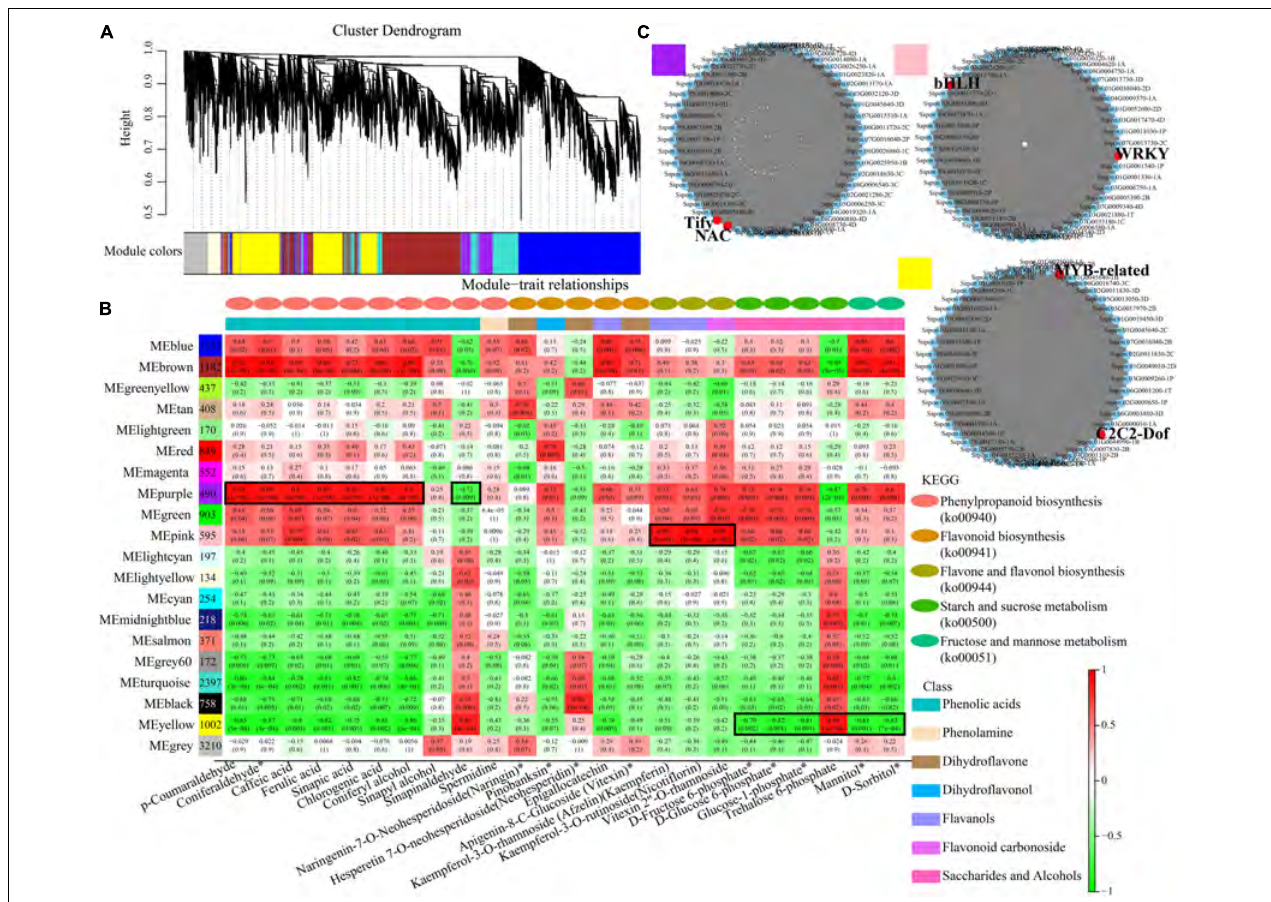
FIGURE 7 | Co-expression network analysis. (A) Hierarchical cluster tree showing 20 modules obtained by weighted gene co-expression network analysis (WGCNA). The gray modules represent genes that are not divided into specific modules. Each branch in the tree points to a gene. (B) Matrix of module-metabolite associations. Combining the gene expression profile data of stem and leaf tissues of different sugarcane varieties and the change patterns of phenylpropanoid biosynthesis, flavone and flavonol biosynthesis, starch and sucrose metabolism, displayed by the WGCNA analysis. The number of genes in each module is shown in the left box, followed by correlation coefficient and p -value between modules and metabolites, which are displayed at the intersection of rows and columns. (C) Co-expression sub-network analysis of purple, pink, and yellow modules related to the accumulation of phenylpropanoid biosynthesis, flavone and flavonol biosynthesis, starch and sucrose metabolism. The first 50 nodes of purple, pink, and yellow modules to build the network were selected, and transcription factors are shown in